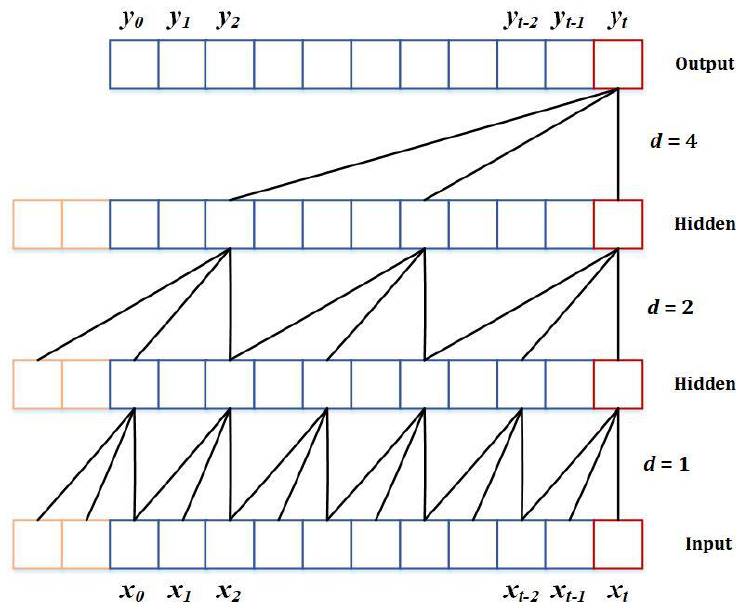
Figure 3. Dilated causal convolution process.